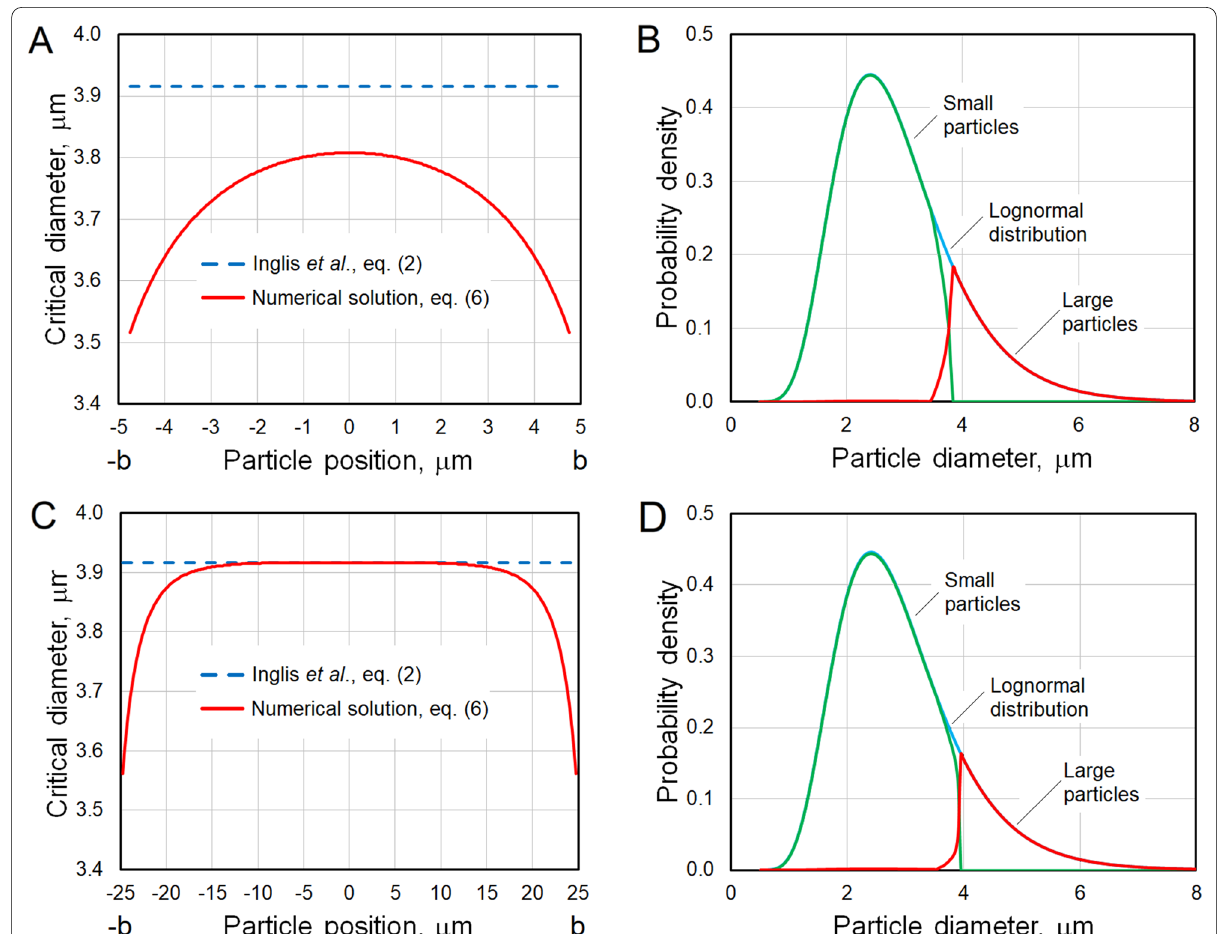
Fig. 4 Variation of critical diameter and efficiency of particle separation. The critical diameter versus the vertical position of particles in shallow A and deep C channels. Idealized separation of small and large particles in shallow B and deep D